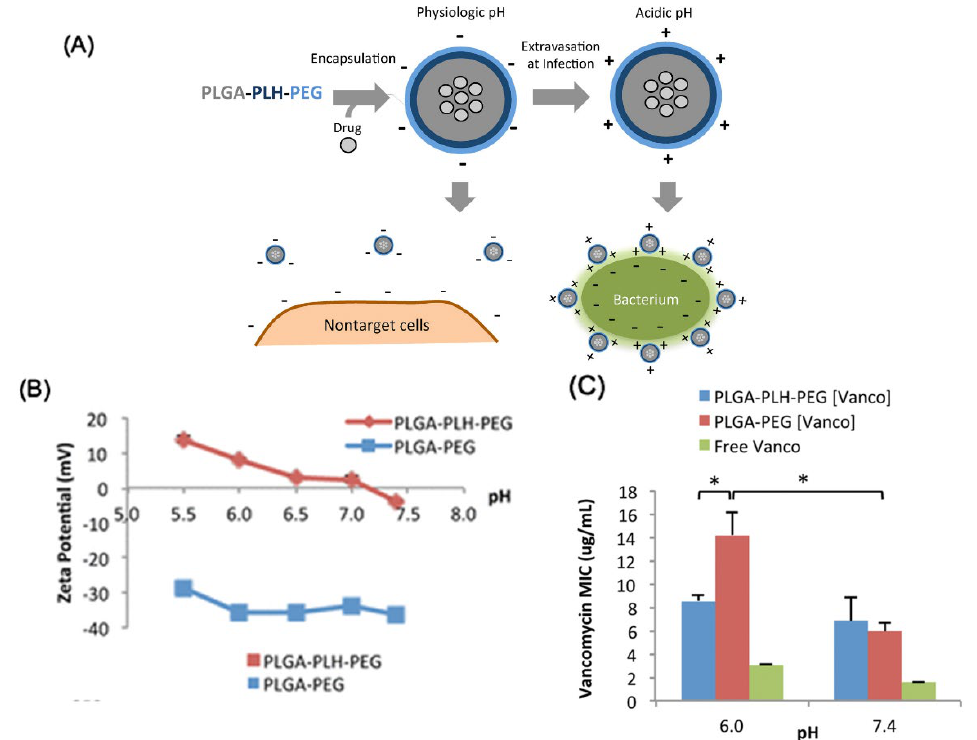
Figure 7. ( A ) Schematic of the nanoparticle-mediated drug targeting bacterial cell walls. A small negative charge and surface PEGylation prevent nanoparticles from attaching to nontarget cells or blood components at physiologic pH 7.4. The surface-charge-switching process activates at weakly acidic infection sites, attaching nanoparticles to negatively charged bacteria. ( B ) PLGA—PLH—PEG nanoparticles convert from anionic to cationic when the pH drops. ( C ) Minimum inhibitory concentrations (MIC) of S. aureus vancomycin formulation. * indicates p < 0.05. Reproduced with permission from [155]. Copyright American Chemical Society, 2012.